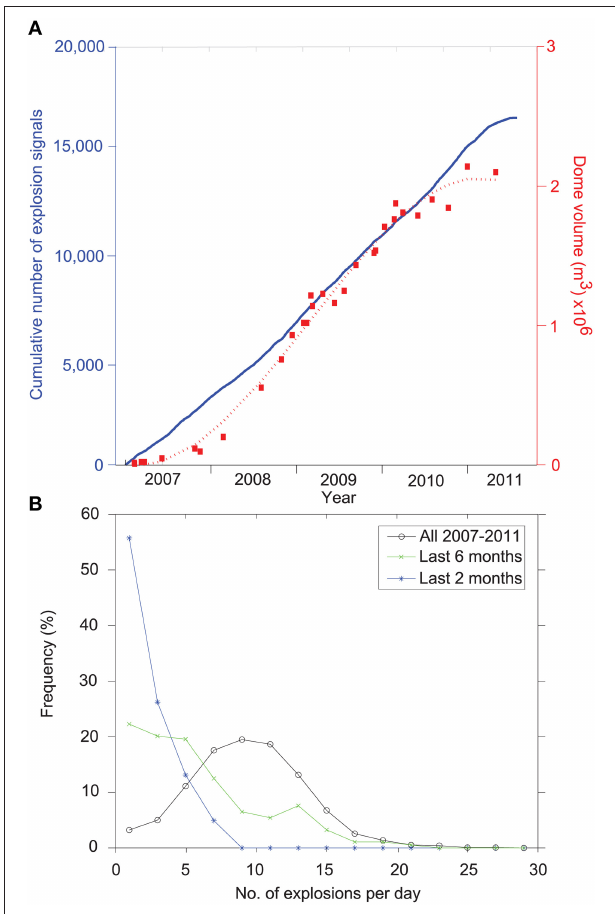
FIGURE 3 | Dome growth and explosion rate: (A) Cumulative number of explosions from recorded seismicity (blue) and measured cumulative absolute dome volume (red) at Volcán de Colima from 1st January 2007 to 12th July 2011. Seismic events were detected manually from data recorded at a short-period instrument (EZV4), located ∼ 1.5km from the vent. Cumulative absolute dome volume is adapted from Hutchison et al. (2013), with the final point calculated using digital photographs of the dome. (B) Histograms of the number of explosions in a day, (picked manually by inspection of the same data-set in panel A) normalized to the total number of explosions in the period for 2007–2011, January–July 2011, and May–July